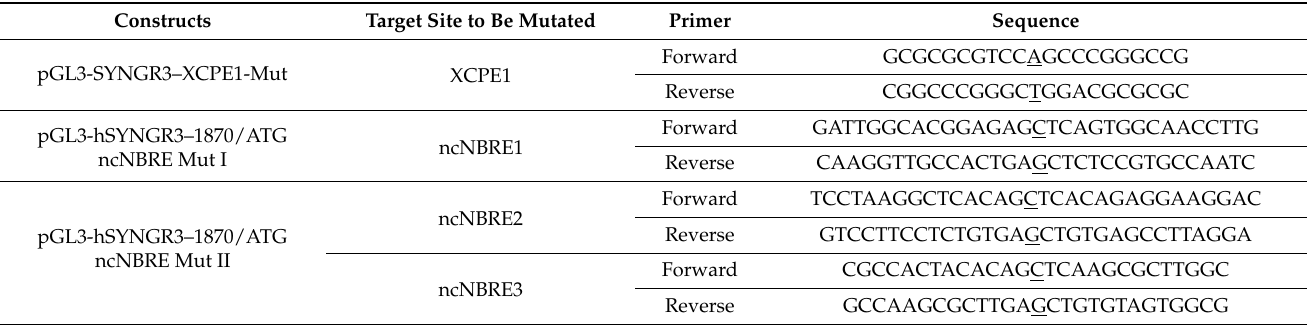
Table 3. Primers used for the site-directed mutagenesis of pGL-SYNGR3